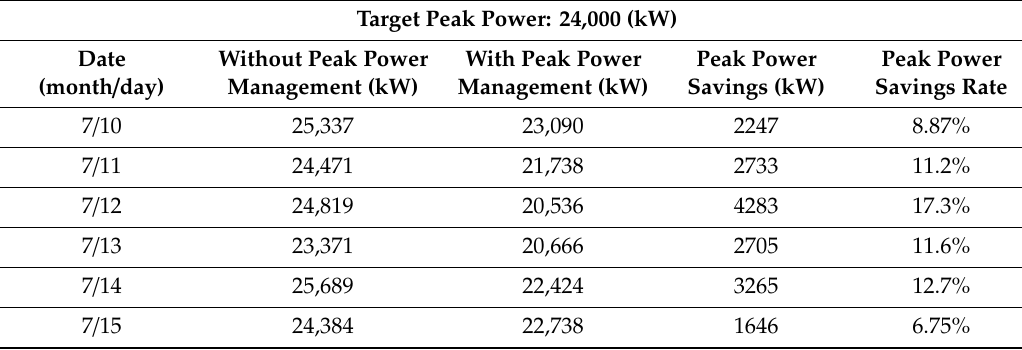
Table 6. Results of PMS Weekly Operational Data Analysis (KEPCO * I-Smart Interlink Analysis Data).